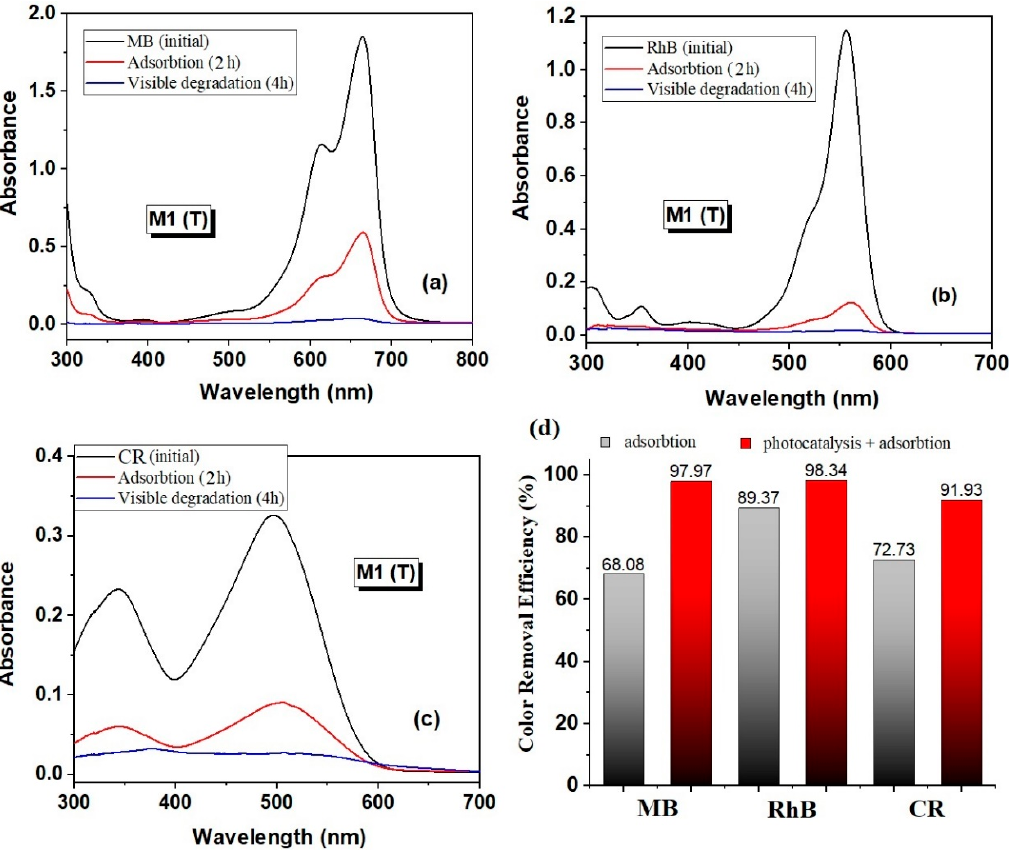
Figure 11. UV–Vis absorption spectra after adsorption (2h) and visible light irradiation (4h) in the presence of sample M1 (T) for degradation of MB ( C 0 = 10 mg/L) ( a ); RhB ( C 0 = 5 mg/L) ( b ); Congo Red (CR) ( C 0 = 10 mg/L) ( c ), and color removal efficiency of all dyes degradation for sample M1 (T) ( d ).